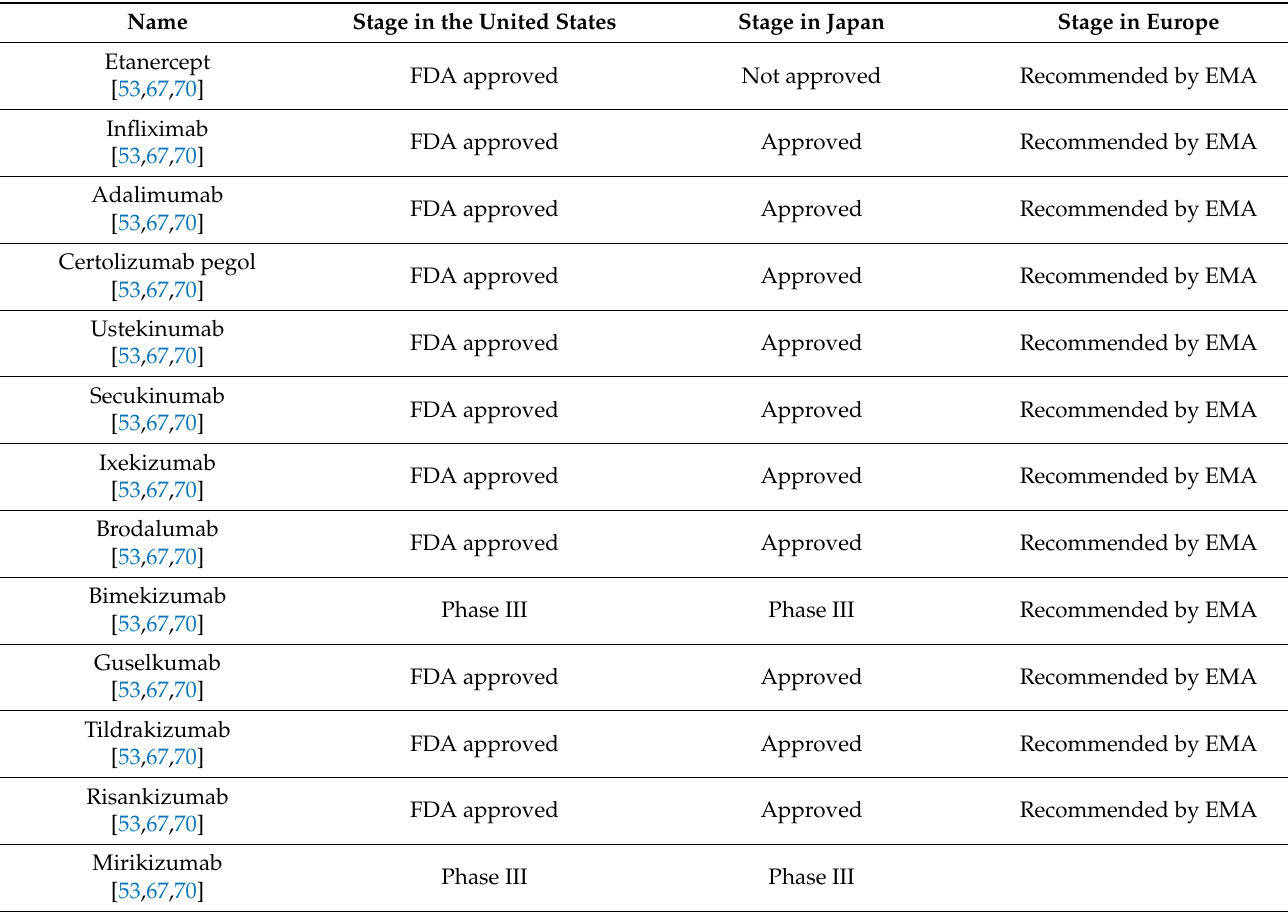
Table 2. Summative Table of Drugs, Stages of Approval in the US, Japan, and Europe, Route and Dose Approved in the US